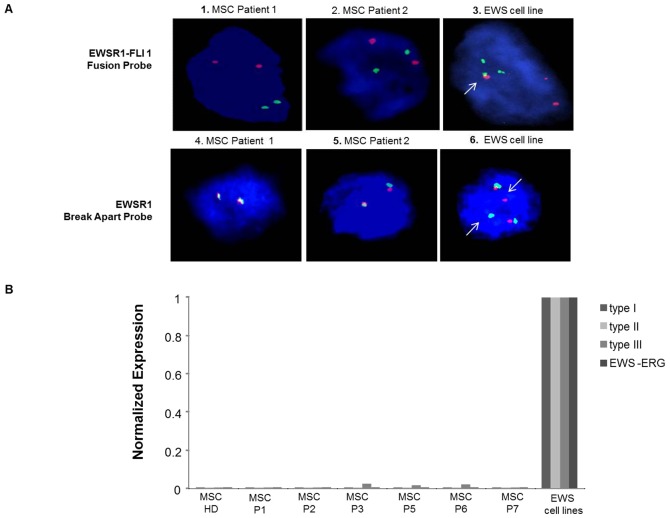
MSC-P lack the presence of the EWSR1-FLI1 chromosomal translocation.(A) Study of the chromosomal translocation between genes EWSR1 and FLI1 using a EWSR1-FLI 1 homemade-fusion probe(1–3). MSC-P showed two normal copies of both EWSR1 and FLI1 (1 and 2) whereas in the TC71 cell line we observed not only two normal copies but also one EWSR1-FLI1 fusion, marked by a white arrow (3) Rearrangements of the EWSR1 gene were studied using a EWSR1 break-apart probe. (4–6) Representative images of MSC-P, EWS-P-01 and EWS-P-02, (4 and 5) failed to present a break in the EWSR1 gene, whereas the positive control here represented by the TC71 cell line (6), showed a distinctive rearrangement of this gene, marked by white arrows. (B) Results were validated by q-RT-PCR using EWS cell lines as a positive control. MSC-P, here represented by Patients 1;2;3;5;6 and 7 as well a healthy donor display a clear negative expression of all the transcripts.